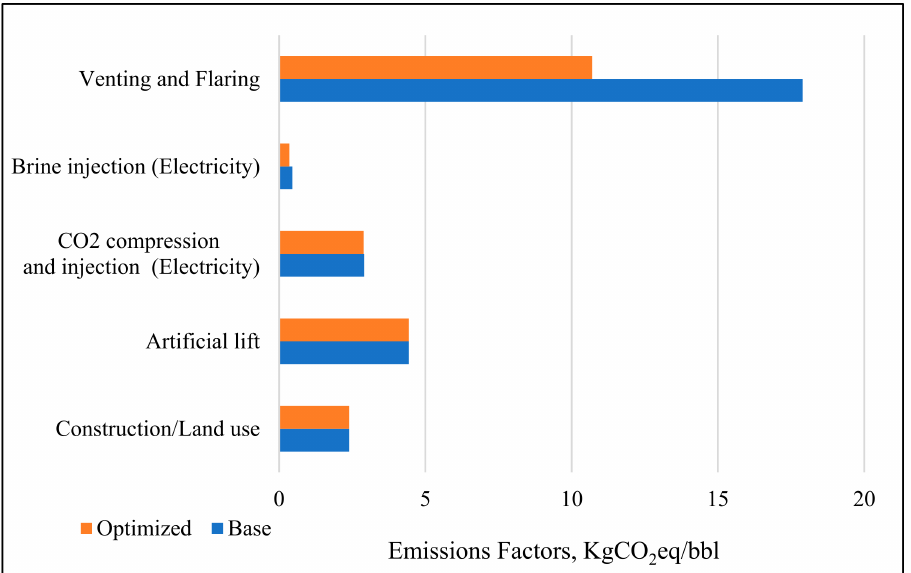
Figure 6. FWU emission factors for Base and forecasted optimized cases.